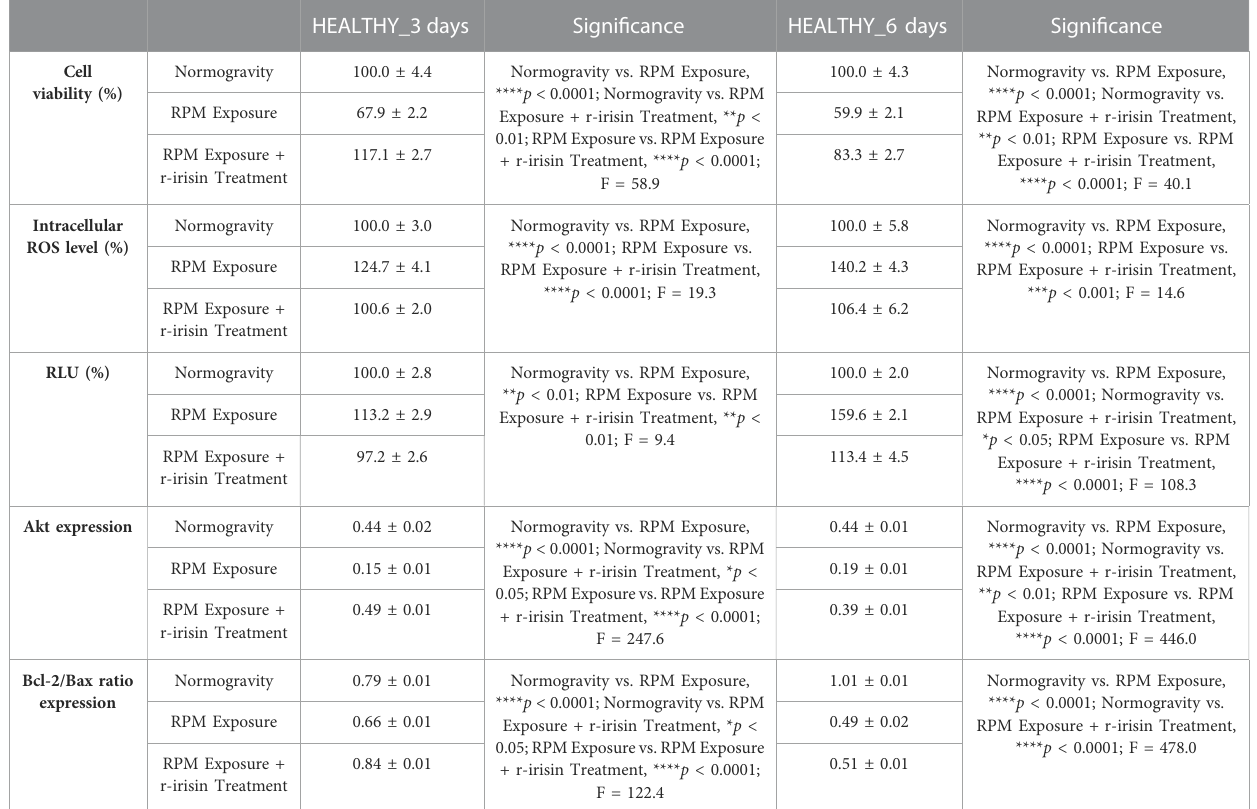
TABLE 2 Mean values ± standard error and relative signi fi cance for the cell survival assessment in HEALTHY subjects after 3 and 6 days of RPM